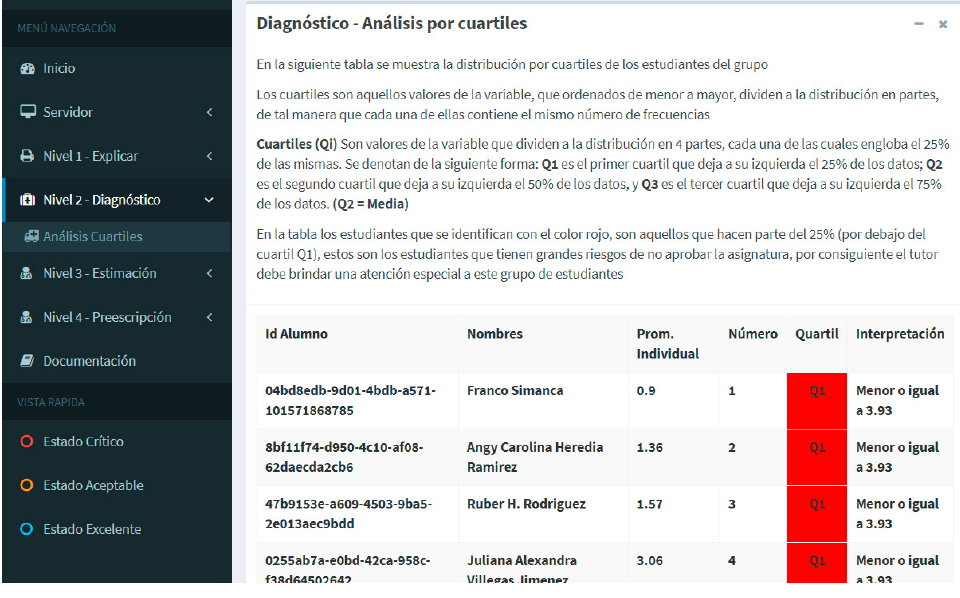
Figure 5. List of course students and the quartiles in which they are found. Those in Quartile 1 are in red, those in Quartile 2 are in yellow, and those in Quartile 3 are in green.